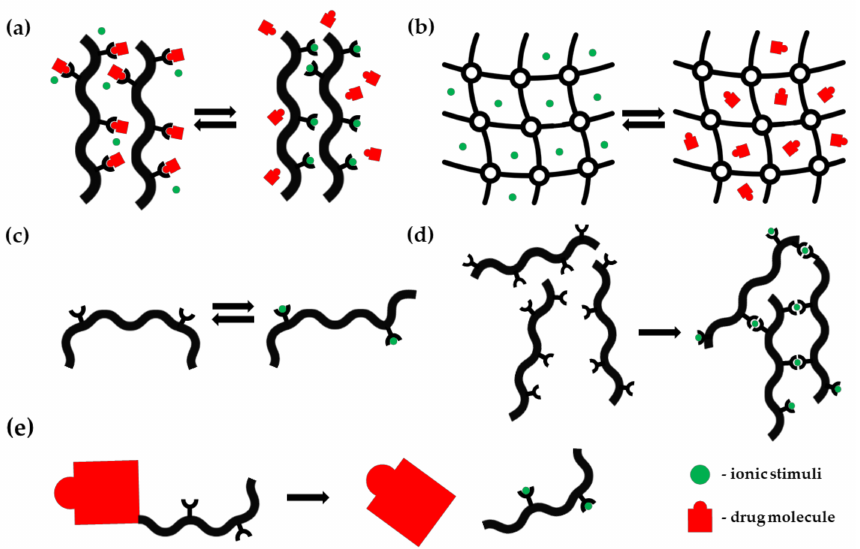
Figure 1. Possible mechanisms of ion-dependent response of pharmaceutical systems: ( a ) ion exchange in polymer resins; ( b ) ion exchange in porous materials; ( c ) conformational change; ( d ) ionic crosslinking; ( e ) prodrug